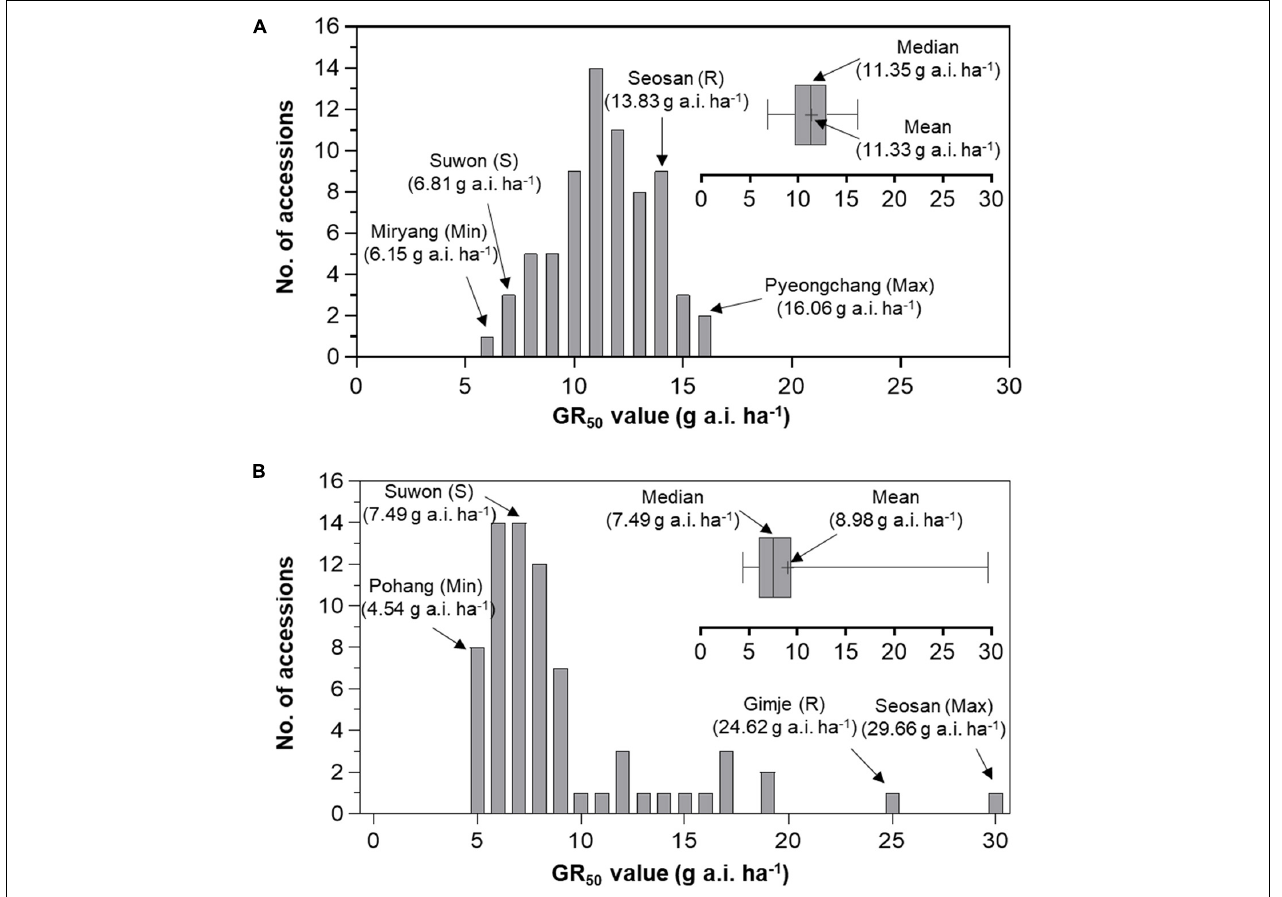
FIGURE 5 | Distribution of GR 50 values of florpyrauxifen-benzyl for (A) Echinochloa crus-galli and (B) Echinochloa oryzicola accessions.